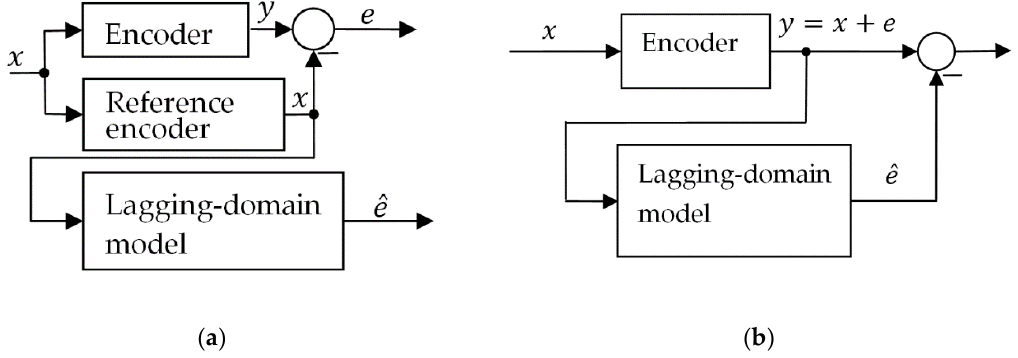
Figure 1. Signal diagram of the encoder and the model. ( a ) The measured error of the encoder is compared to the result of the simulation with the Lagging-domain model. ( b ) The Lagging-domain model is used for compensation of the hysteresis error of the encoder. Since the reference angle is not known in this case, the output of the encoder is used as an input of the model. Table 1. List of used symbols.